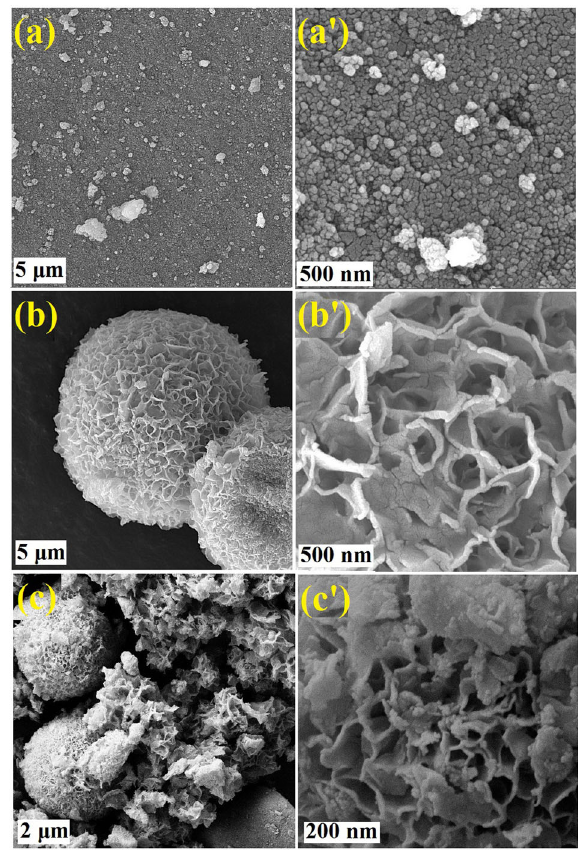
Fig. 2 FE-SEM images. a, a ʹ SmVO 4 . b, b ʹ SnIn 4 S 8 . c, c ʹ SnIn 4 S 8 / SmVO 4